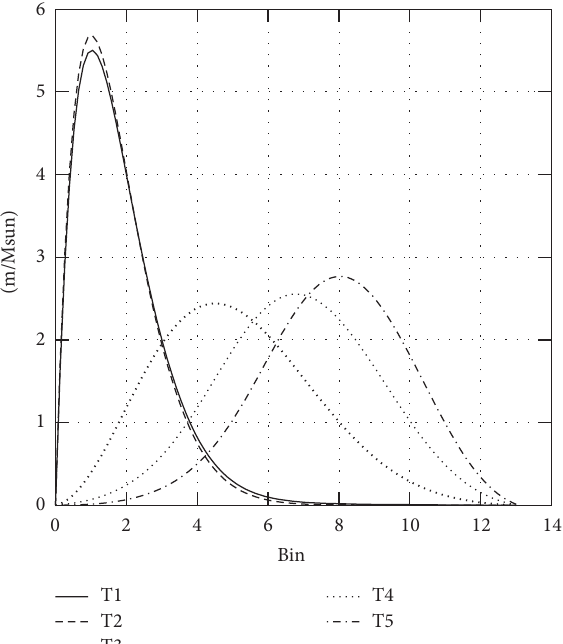
Figure 6: Time evolution of the peak density for all the T models.